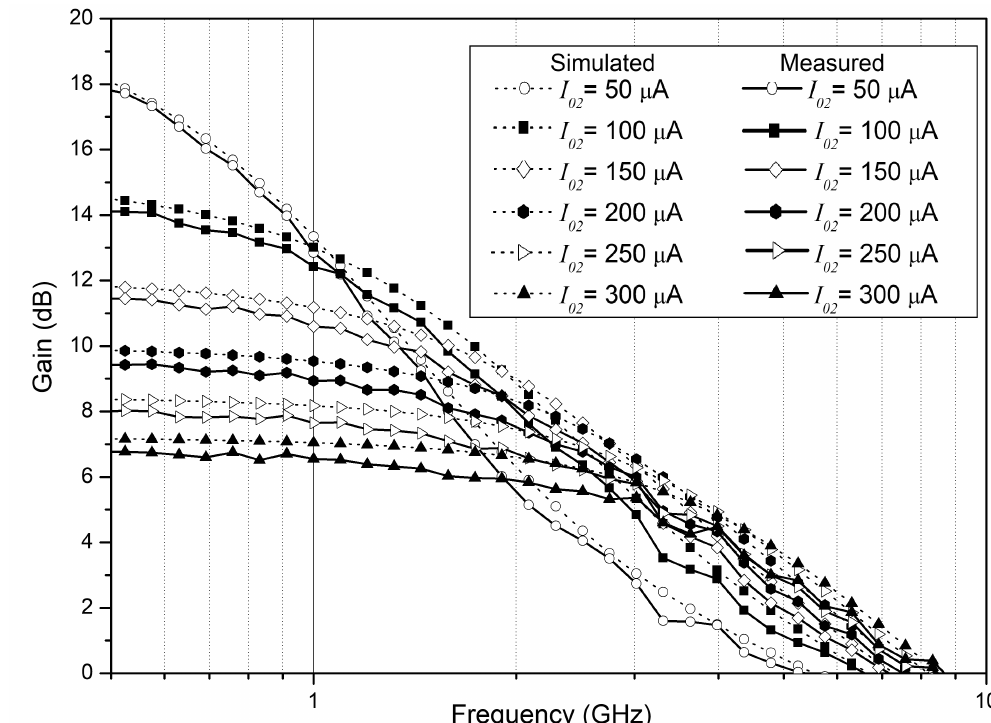
Figure 10. Measured and simulated gain of the RF-VGA for different bias currents I 02 .